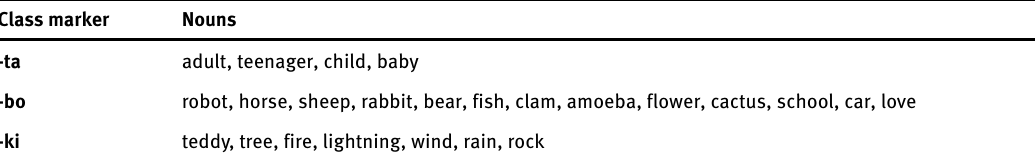
Table 2 : An example language produced at the end of a chain in the experiment, with nouns grouped by markers used. This language shows a clear effect of animacy, with -ta used exclusively for humans, and -ki being used for natural forces and three of the other